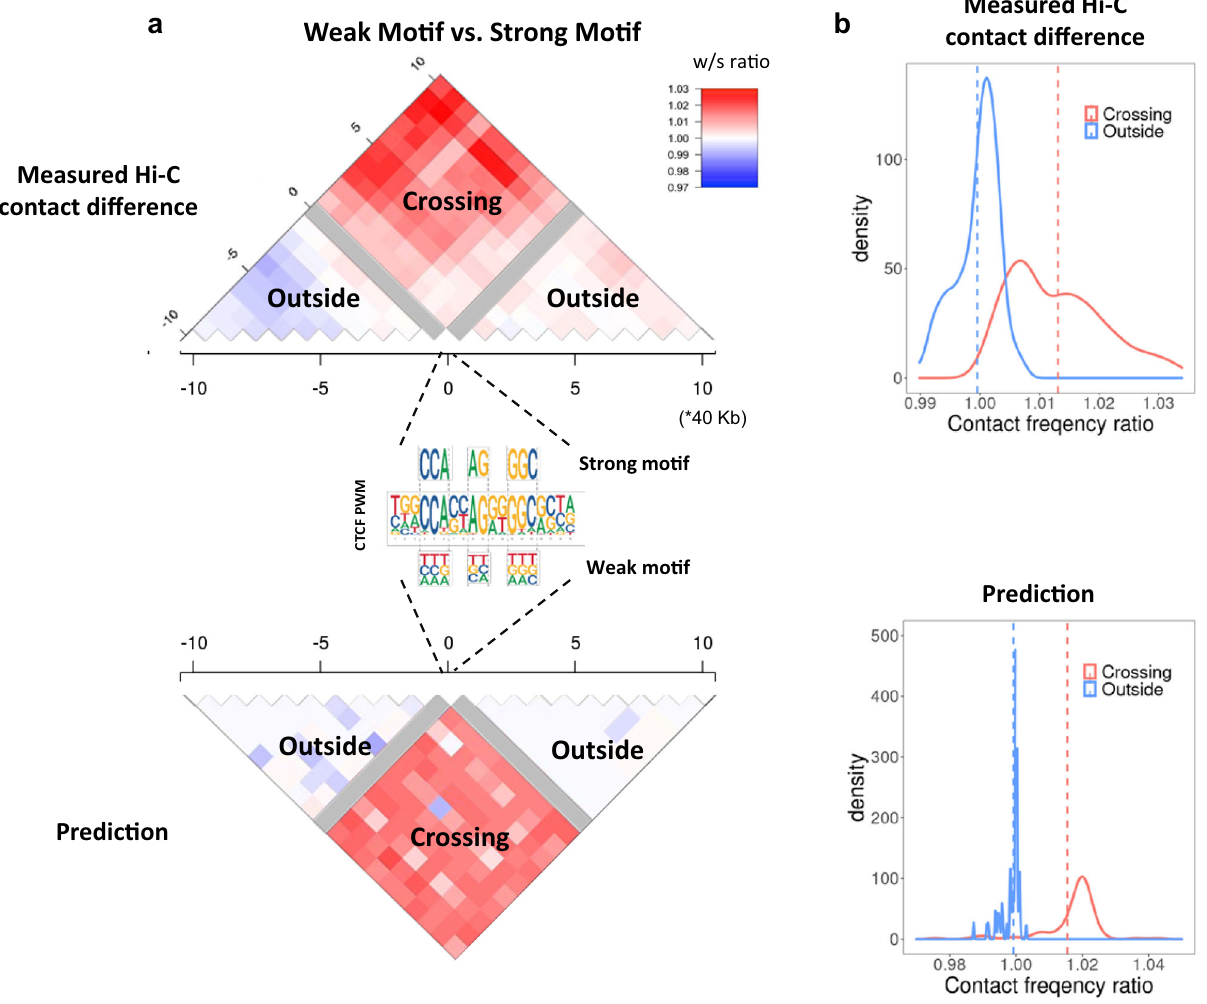
Fig. 6 Loop competition predictions are consistent with changes in chromatin interaction frequency induced by naturally occurring CTCF-binding site disruption. a Measured differential Hi-C contact frequency fl anking SNP disrupted CTCF sites. The contact ratio for weak vs. strong CTCF motif genotype in a population of 20 individuals 37 is shown. The heatmap is partitioned into 40 kb bin pairs. Gray bins directly overlap the disrupted CTCF-binding site on one end, and loops which span the CTCF motif (Crossing) or do not span the CTCF motif (Outside) are indicated. Only loops which span the disrupted CTCF motif have increased contact frequency (top, red), consistent with reduced loop competition from our model predictions (bottom). Only SNPs which disrupt the indicated informative positions in the CTCF motif are used, and the strong or weak versions are labeled on the PWM from Jaspar MA0139.1. b The same data is used to generate the contact frequency ratio distribution for the two classes (Crossing and Outside) of bin pairs for measurements (top) and our model predictions